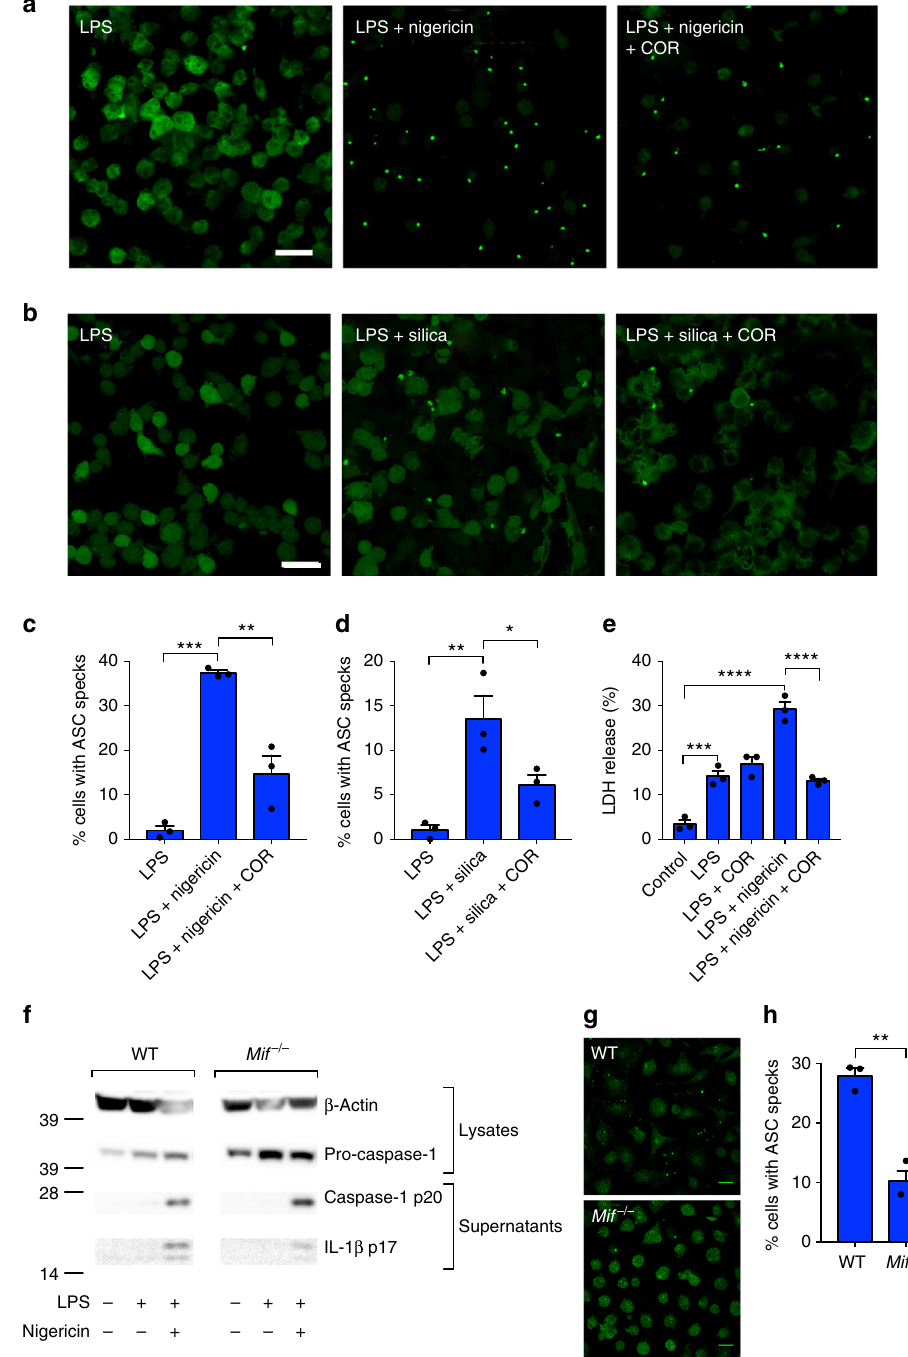
Fig. 5 Inhibition of MIF prevents NLRP3 in fl ammasome activation. ASC-cerulean macrophages were primed with LPS (10 ng ml − 1 ) overnight. The following day cells were treated with COR123625 (50 µ M) for 2 h before activation of the in fl ammasome with a nigericin (10 µ M) (1 h) or b silica (150 µ g ml − 1 ) (4 h). Confocal images are representative of three independent experiments. c , d Data are presented as the percentage of ASC-speck-positive cells. Data shown are mean ± SEM of three independent experiments. e WT BMDMs were left untreated, treated with LPS alone (100 ng ml − 1 ) for 5 h, treated with COR123625 for 1 h prior to the addition of LPS, primed with LPS before in fl ammasome activation with nigericin (5 µ M) for 1 h, or treated with COR123625 before LPS and nigericin stimulation. Levels of LDH release were quanti fi ed using the Promega cytotoxicity assay. f WT or Mif − / − BMDMs were treated with LPS (10 ng ml − 1 ) + nigericin (5 μ M) and lysates and supernatants analyzed by Western blot for caspase-1 and IL-1 β . Images are representative of >3 mice. g BMDMs from WT and Mif − / − mice were treated with (10 ng ml − 1 ) + nigericin (5 μ M), fi xed and stained for ASC, and analyzed by confocal microscopy. Images are z projections of multiple z-stacks. h Quantitation of ASC specks in g , n = 3 mice per group. Data are expressed as percentage increase of mean ± SEM from three mice. * P < 0.05, ** P < 0.01, *** P < 0.005, or **** P < 0.001, one-way ANOVA with a correction provided by the